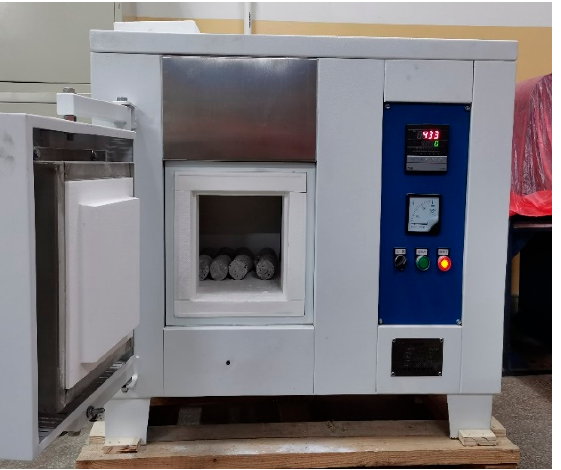
Figure 2. Box-type resistance furnace.